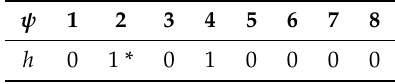
Figure 11. Median AB results with non-parametric 95% CI for each test sound location ( ψ ): ( a ) ψ = 1, ( b ) ψ = 2, ( c ) ψ = 3, ( d ) ψ = 4, ( e ) ψ = 5, ( f ) ψ = 6, ( g ) ψ = 7 and ( h ) ψ = 8. Reference and anchor scores omitted. Score indicates perceived timbral consistency between the three tested orders of Ambisonics. Table 7. Hypothesis tests of the AB test results for each test sound location using Wilcoxon signed-rank test (1 indicates statistical significance at p < 0.05; * indicates p <